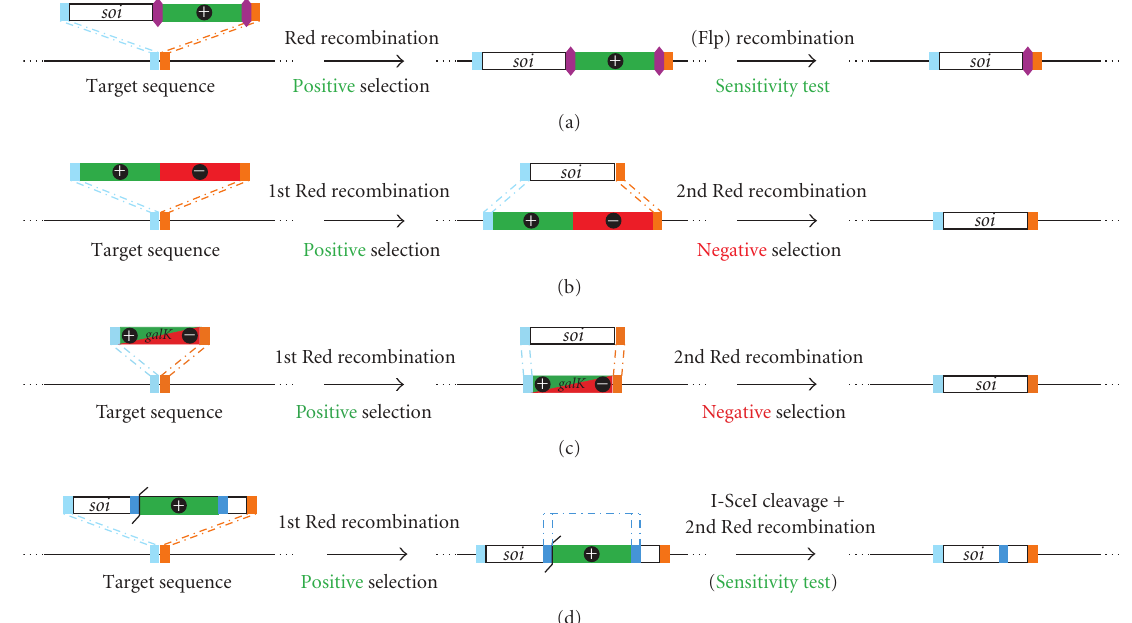
Figure 3: Overview of techniques that facilitate the insertion of a sequence of interest ( soi ) into a target site. Boxes of same color represent identical sequences.